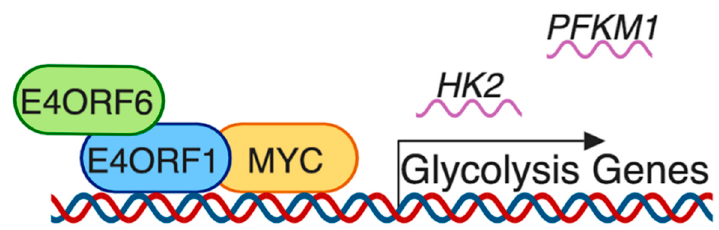
Figure 5. Schematic of how E4ORF1 contributes to MYC-regulated transcription of genes involved in glycolysis according to Thai et al. [26]. E4ORF1 binds to MYC, enhancing the transcriptional activity of MYC, leading to increased transcription of metabolic genes such as HK2 and PFKM1 . E4ORF1 can also bind glycolytic genes, which may be how E4ORF1 brings MYC into proximity of these target genes. E4ORF6 appears to play a scaffolding role and enhances E4ORF1 binding to MYC, although E4ORF6 does not appear to bind MYC or glycolytic genes itself [26]. Created with BioRender.